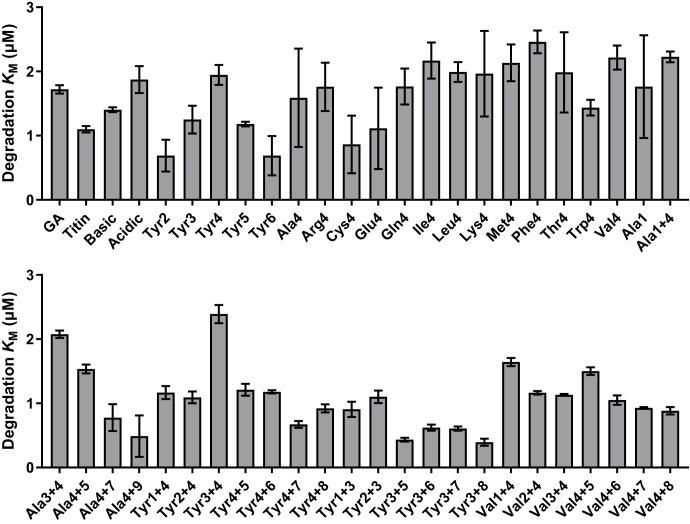
Comparison of KM values for substrates tested in vitro; comparison of fitted values for KM for substrate degradation.Values are the average of three biological replicates ± S.D. None of the substrates exhibited a substantial increase in KM, indicating that differences in degradation rates result from differences in grip rather than in initial substrate recognition.